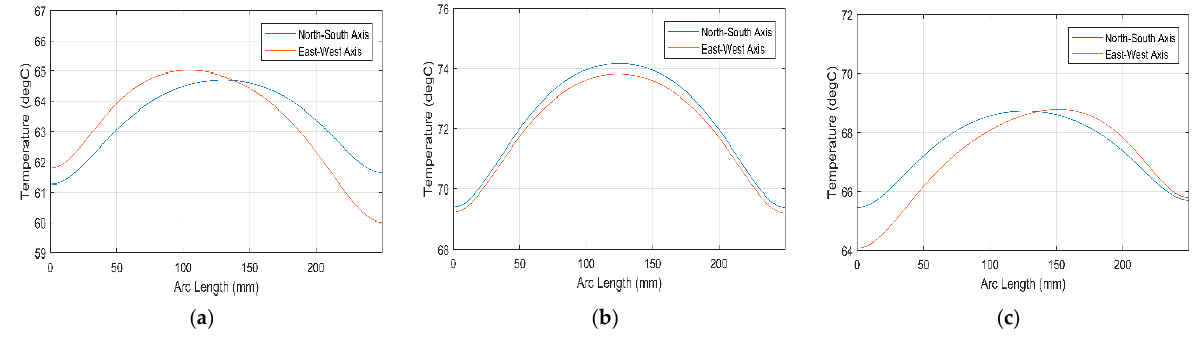
Figure 16. Temperature profile of the triangular SHC with a reflector at ( a ) 9:00; ( b ) 12:00; ( c ) and 15:00 on 1 July 2022.